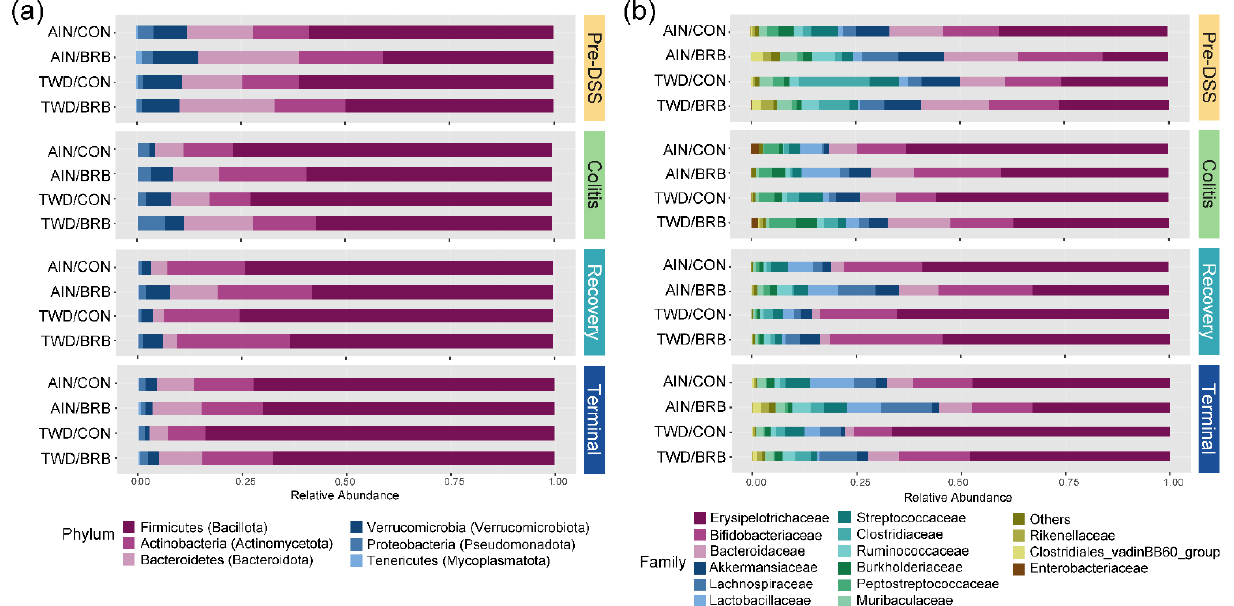
Figure 6. Taxonomic classification of mouse fecal bacteria (experiment B). Data shown are the relative normalized abundance of bacteria annotated to phylum ( a ) or family ( b ) taxonomic levels for the top 15 most abundant taxa for each experimental group for each experimental time point. New phylum level taxonomic designations are indicated in parentheses ( a ).